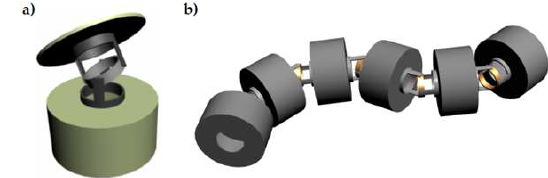
Figure 1: Mechanical design of the snake robot. (a) A segment of the snake consisting of a hol- low cylinder and a plate, connected by a 2 DOF joint. (b) Mechanically assembled snake robot consisting of 5 segments and an extra cylinder in the front, representing the head or brain of the snake robot.